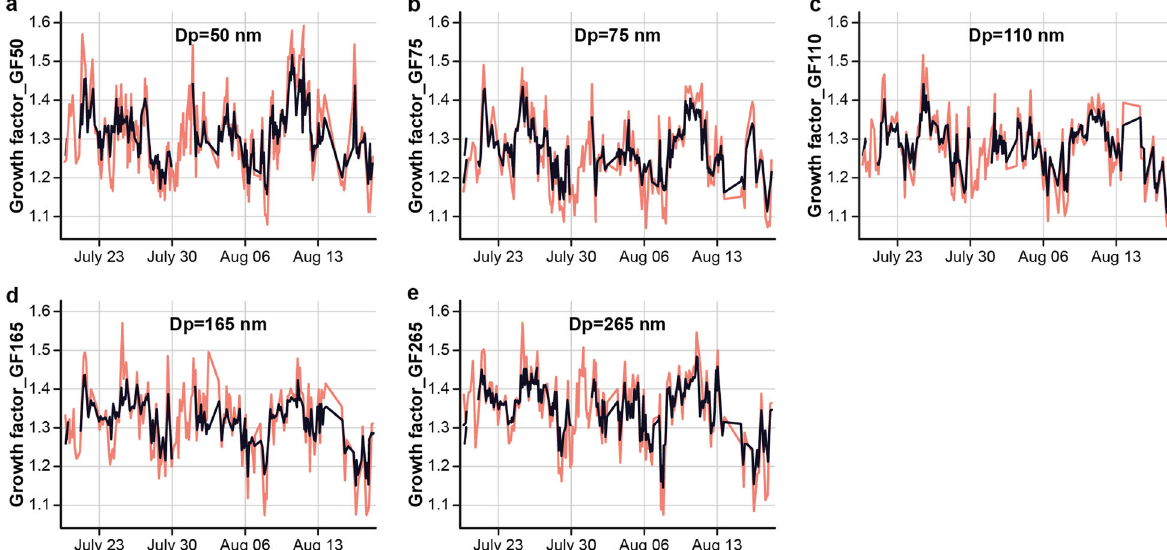
Fig. 6 Comparison of time series of observed growth factors (in red) with those modelled using Random Forest (in black). Each graph relates to a particle size, as